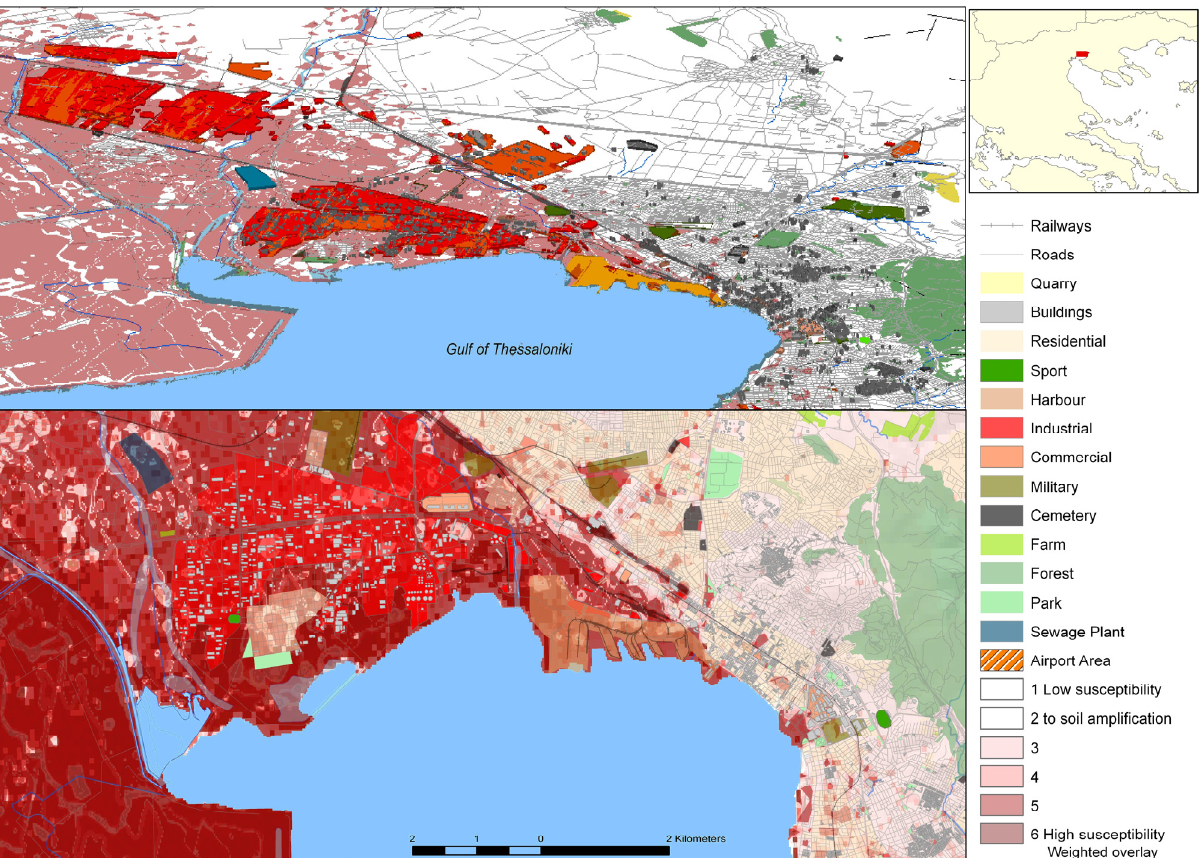
Figure 10. Industrial areas (red) situated in areas with higher susceptibility to soil amplification